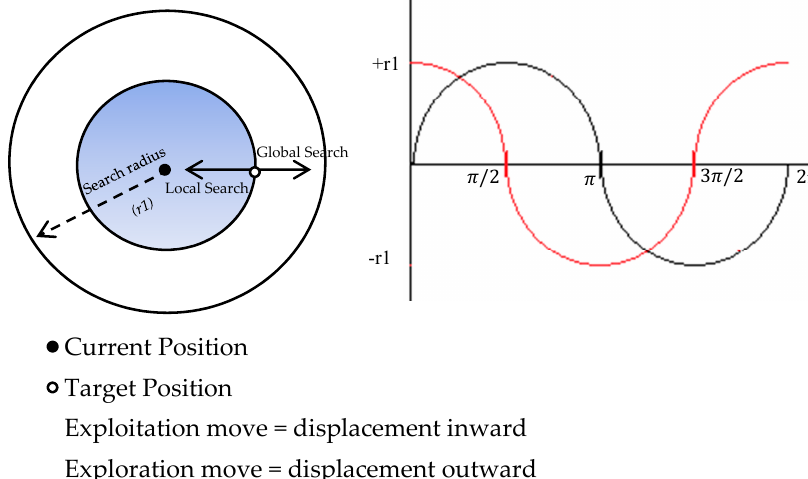
Figure 1. E ff ects of sine and cosine on search radius Figure 1. Effects of sine and cosine on search radius [17].